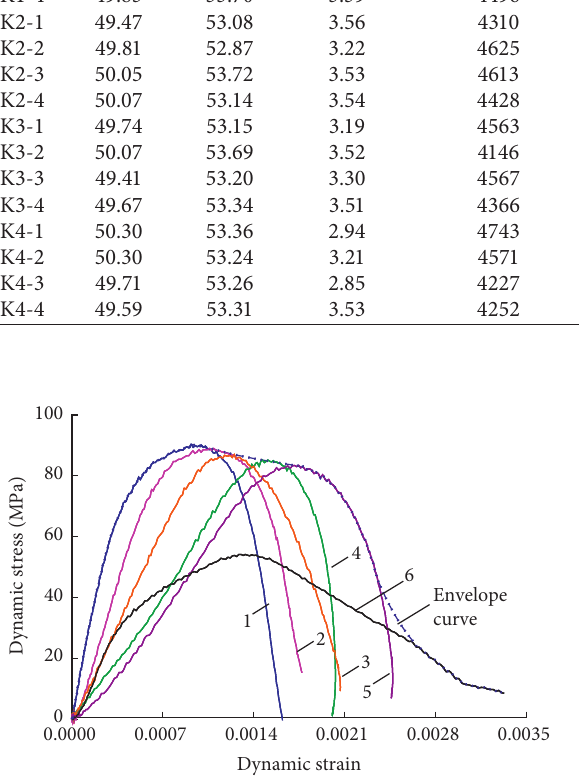
Figure 2: Dynamic stress - strain curve and envelope curve of skarn under the common action of high static stress unloading and impact disturbance (axial load 95 MPa and unloading rate